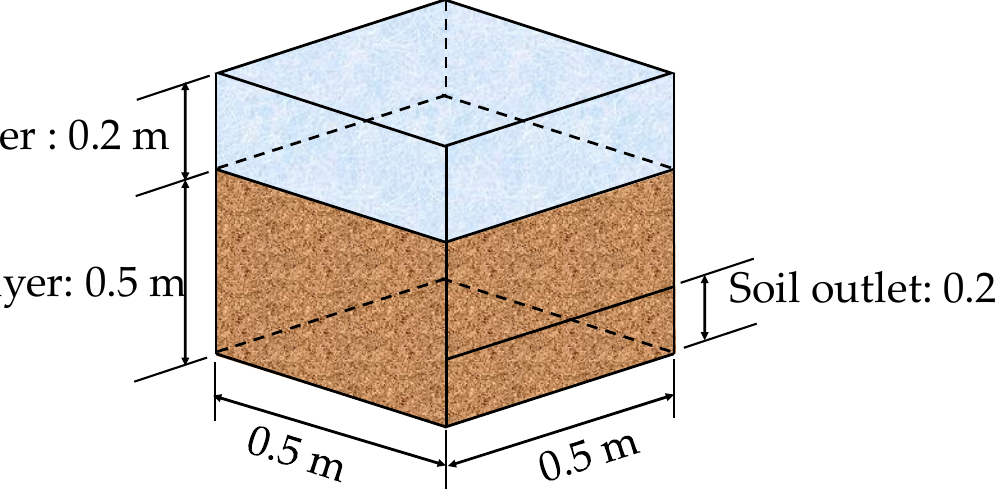
Figure 7. Properties of variable head permeability model .